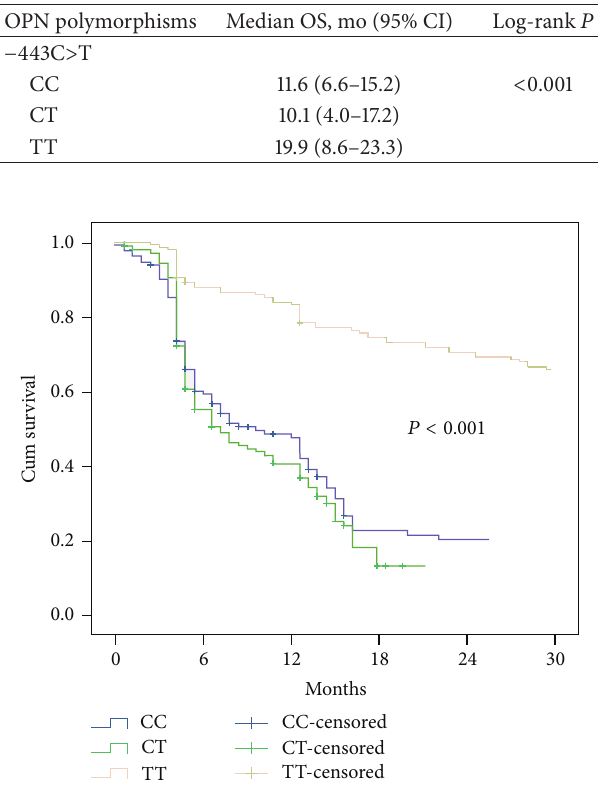
Figure 1: The Kaplan-Meier curves for the effect of − 443CC, − 443CT, and − 443TT genotype on OS in NSCLC patients.